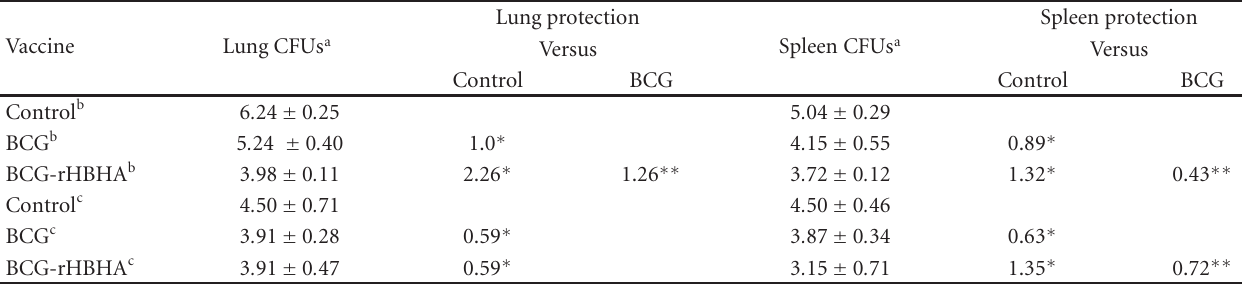
Table 1: Di ff erential recombinant HBHA boosting e ff ect of BCG-induced protective immunity in BALB/c newborn mice against M. tuber- culosis H37Rv infection as measured by reduced bacterial load in spleen and lungs. Lung protection Spleen protection Vaccine Lung CFUs a Spleen CFUs a Versus Versus Control BCG Control BCG Control b 6 . 24 ± 0 . 25 5 . 04 ± 0 .